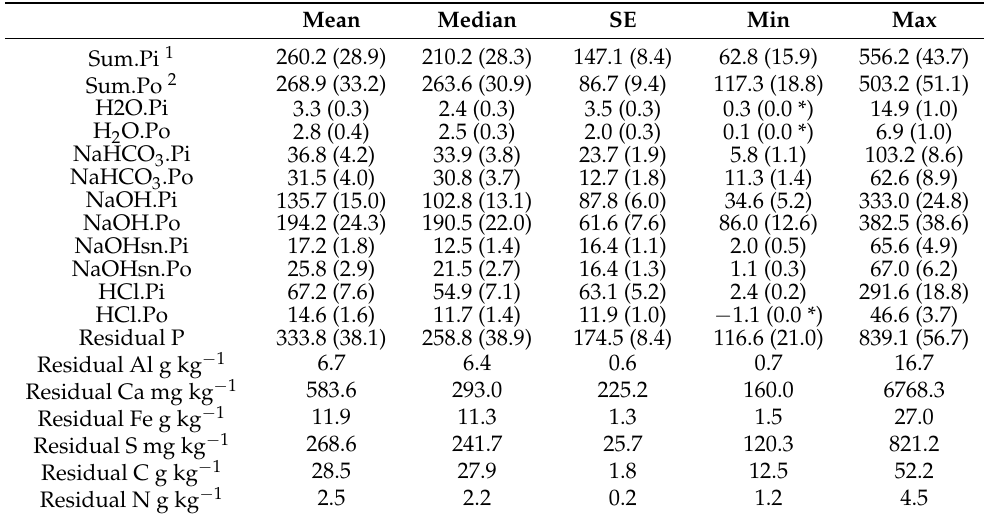
Table 2. Summary statistics of soil phosphorus (P) fractions (mg P kg − 1 ) and residual soil elemental composition from grassland soils (n = 29). Values in brackets correspond to the proportion of each P fraction as percentage of total soil P in each P